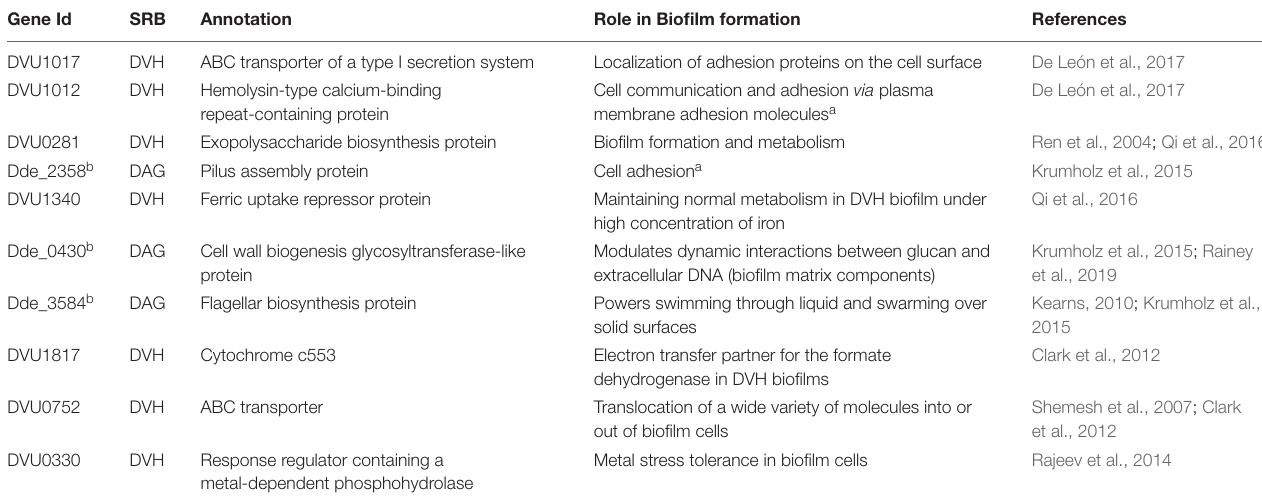
TABLE 1 | Selected genes that impact biofilm formation by sulfate-reducing bacteria